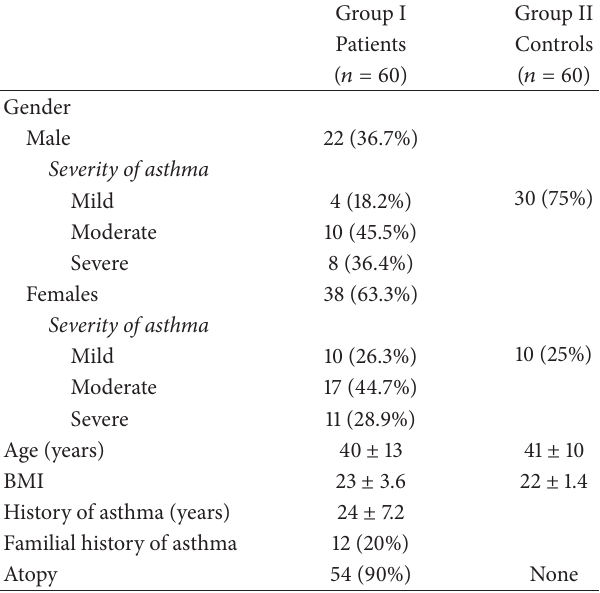
Table 2: Distribution of patients and control groups.